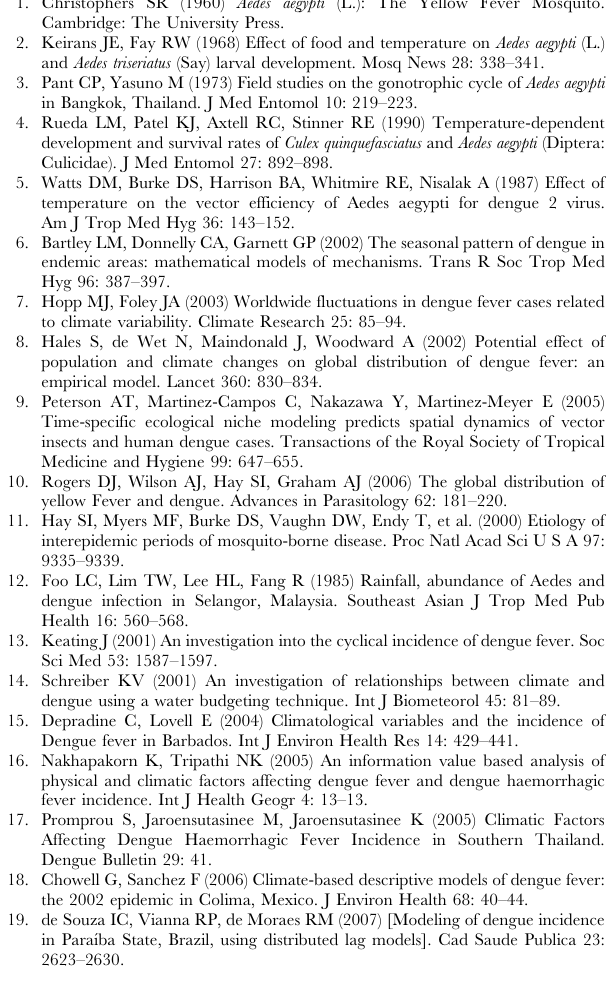
Figure 2. Adjuntas is a small rural municipality in the central mountains near photo B in Figure 2. Ponce is a large mostly-urban municipality on the South coast near photo C in Figure 2. Temperature and precipitation represent the range of values produced in the weather models. High variability in predicted precipitation is